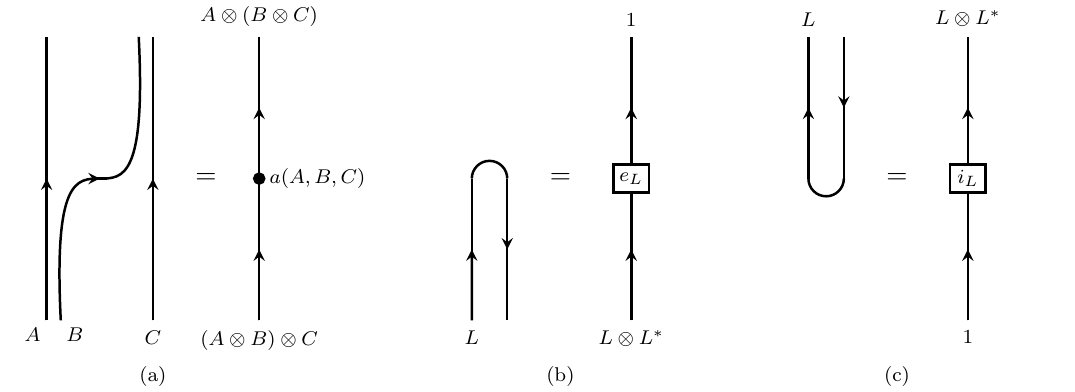
Figure 4 . Canonical maps: (a) Associator a ( A; B; C ), (b) Evaluation e L , and (c) Co-evaluation i L . identities which guarantee that a topologically equivalent graph (cid:0) 0 evaluates to the same morphism m